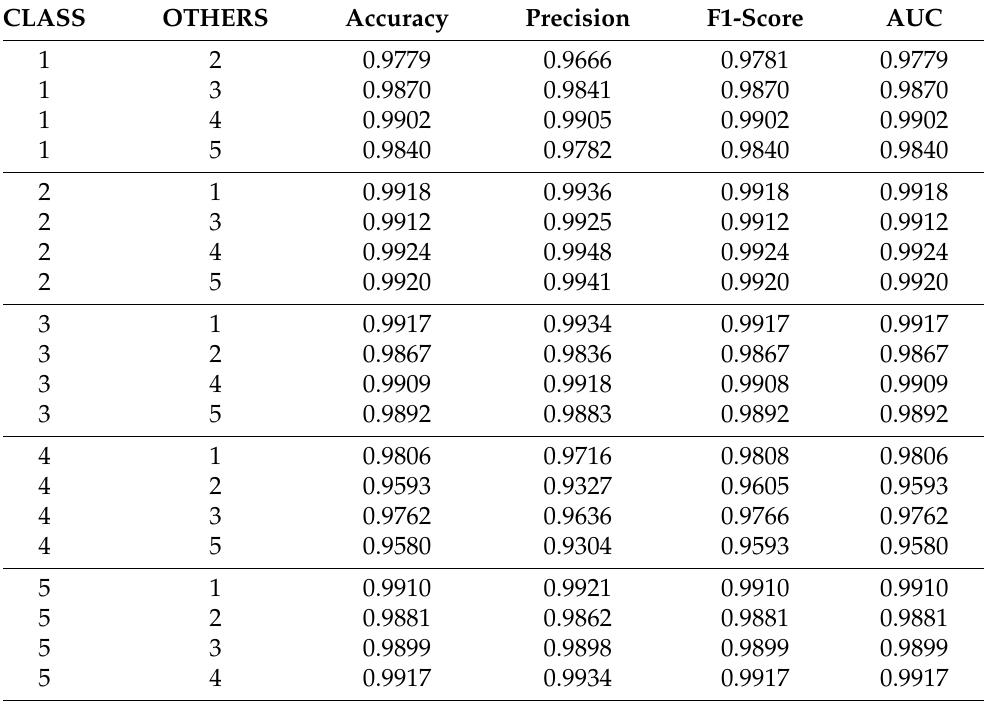
Table 1. DBN-driven iF identification